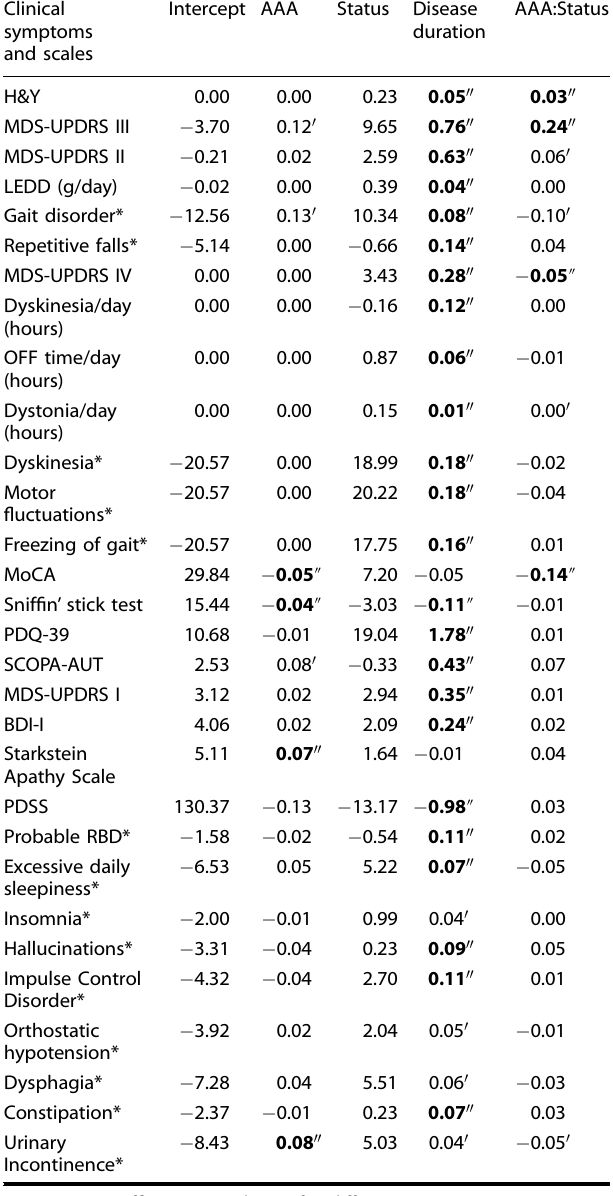
Regression coef fi cients are shown for different outcomes (rows). Status takes the value 0 for HC and 1 for PD, the AAA:status is the interaction term of AAA and being PD (status = 1). Single and double ticks indicate signi fi cance at the 5% level and the Bonferroni-adjusted 5% level respectively, the bold indicates signi fi cant effect where minus value indicates negative signi fi cant effect and positive value positive signi fi cant effect respectively. The column AAA:status indicates whether the effect of AAA on clinical outcomes differs between PD and HC. The binary variables are annotated by asterisk. Clinical symptoms and scales are described in Supplementary